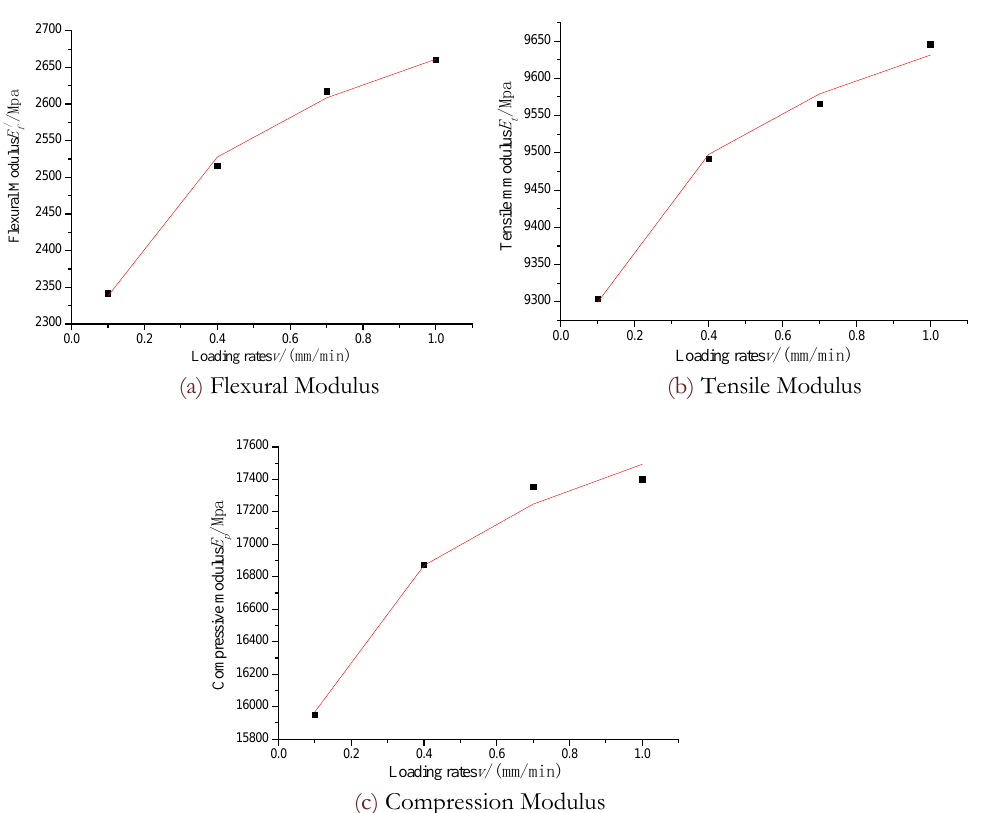
Table 3: Summary of Three Modulus Fitting Results under Different Loading Rates.